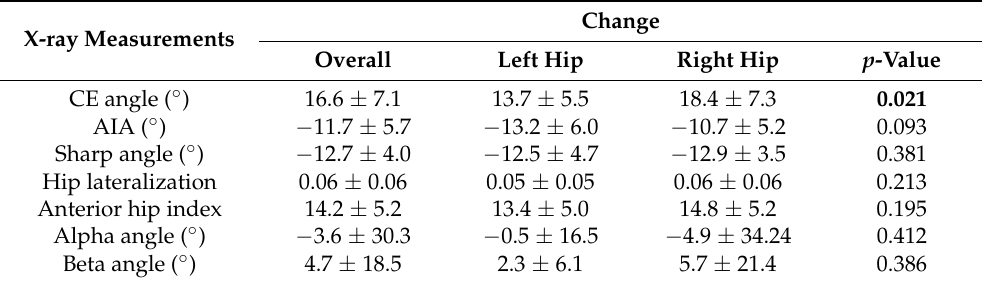
Table 4. Changes in radiographic parameters between the two groups. (Bold values denote statisti- cal